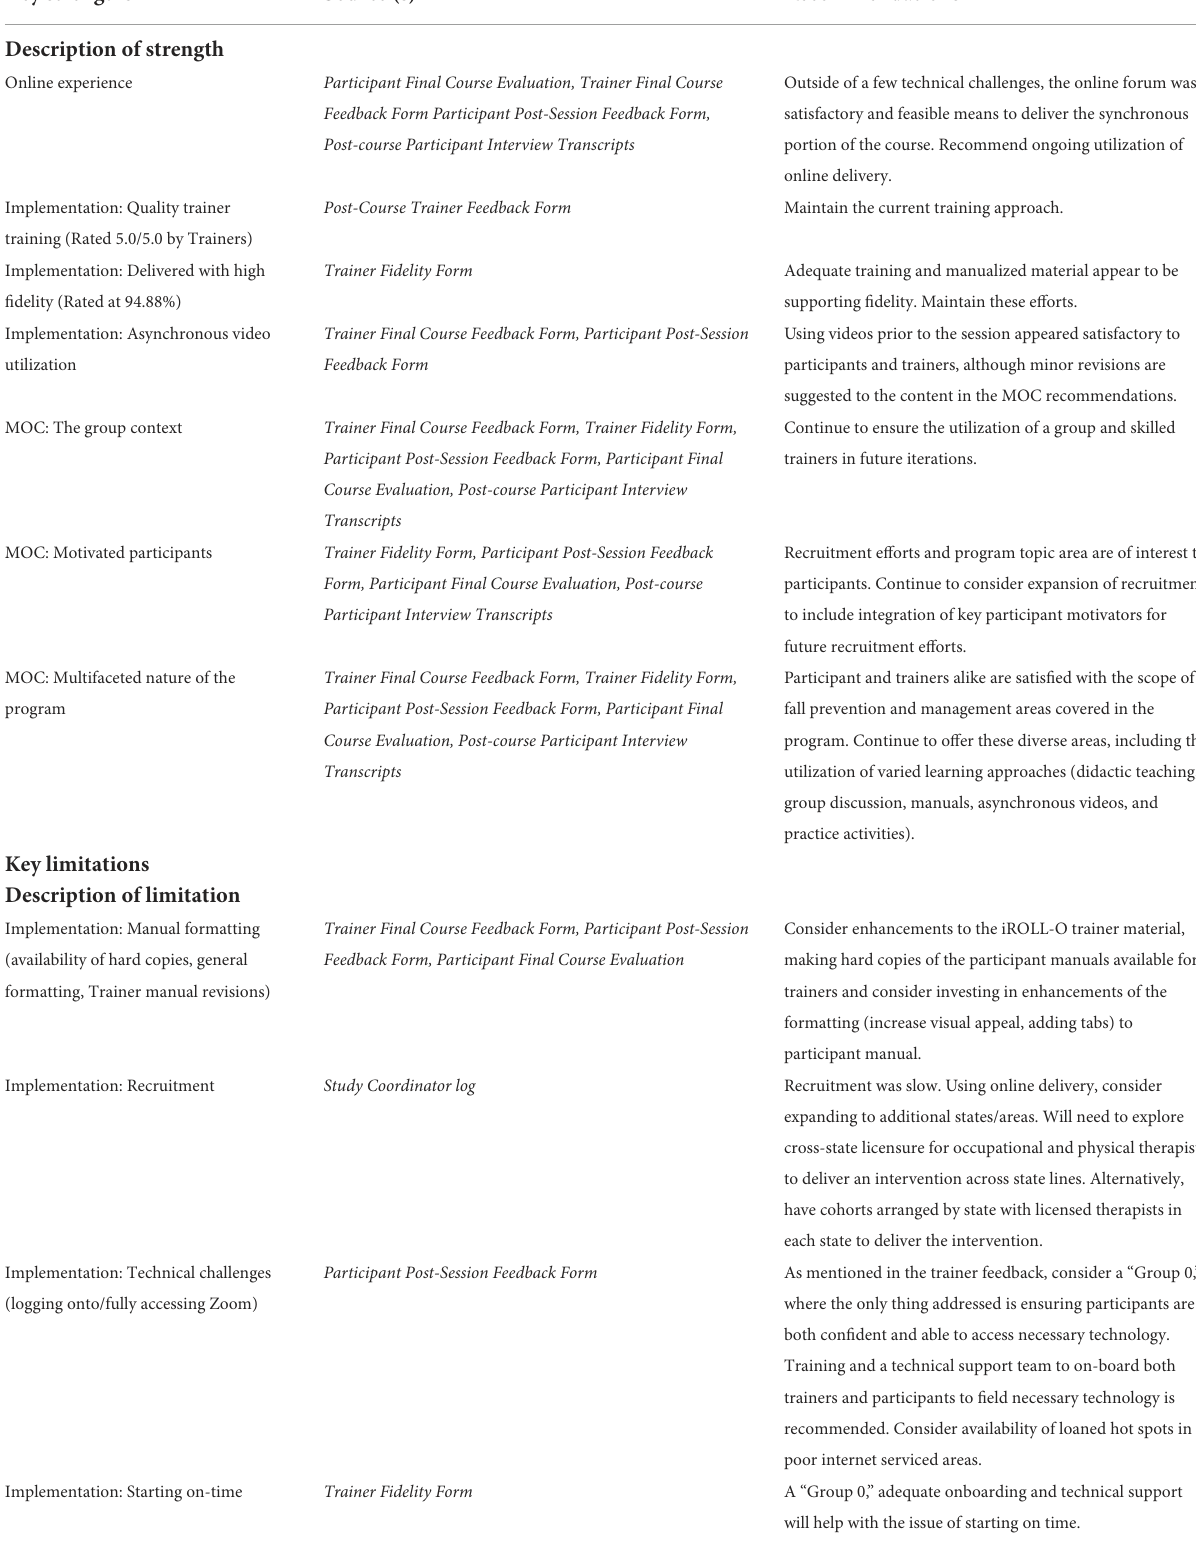
TABLE 9 Summary of iROLL-O’s strengths, limitations, and